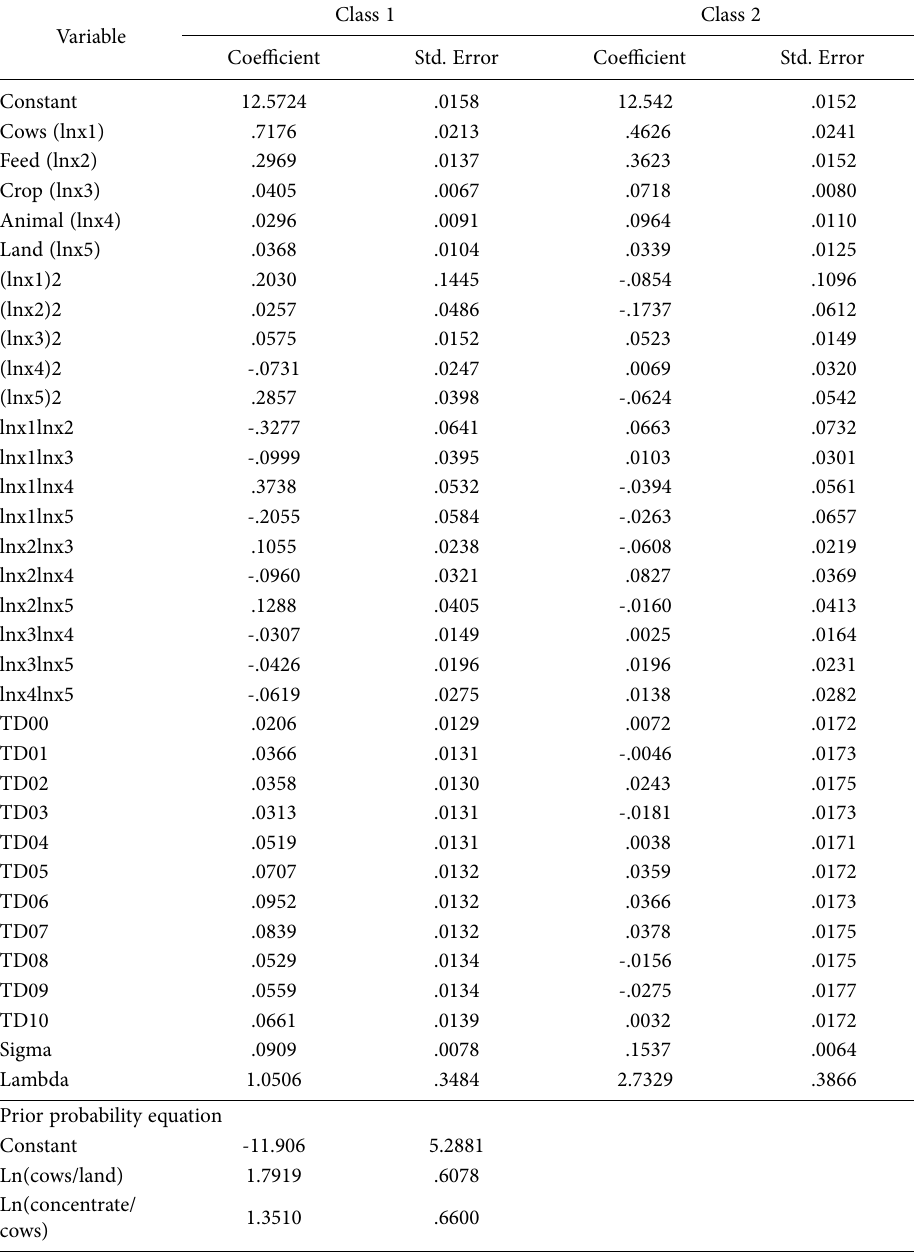
Table A. 1. Estimation of the Panel